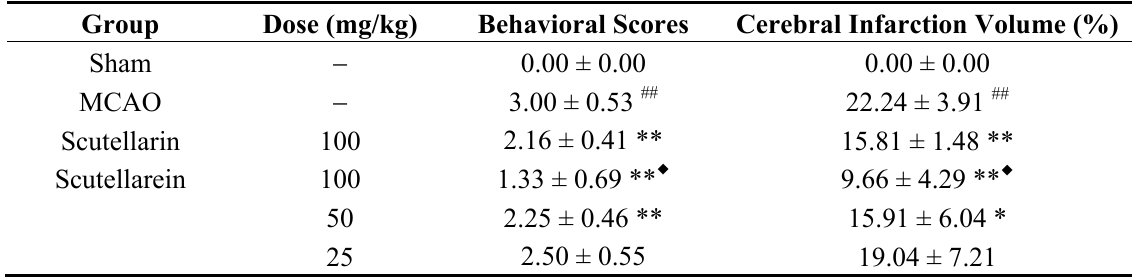
Table 2. The effect of scutellarein on neurological scores and cerebral infarct volume in MCAO rats ( ± s , n =